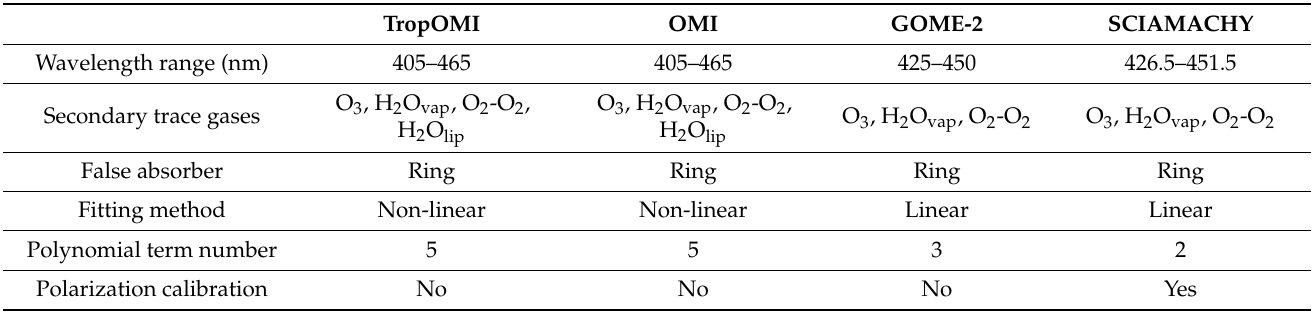
Table 1. NO 2 inversion algorithm of TropOMI compared with previous sensors(Adapted with permission from Ref. [41]. 2017, Gu, J.; Chen, L.; Yu, C.; Li, S.; Tao, J.; Fan, M.; Xiong, X.; Wang, Z.; Shang, H.; Su, L.).